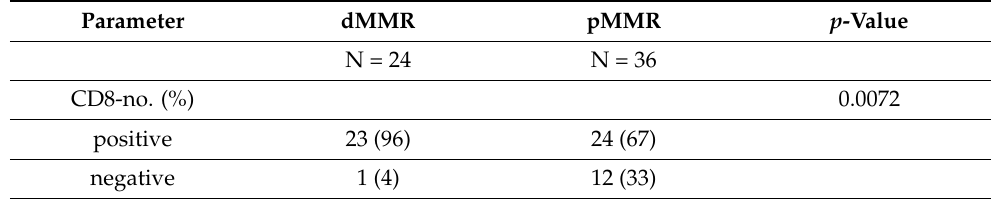
Table 2. Relationship between status of MMR and CD8 expression.